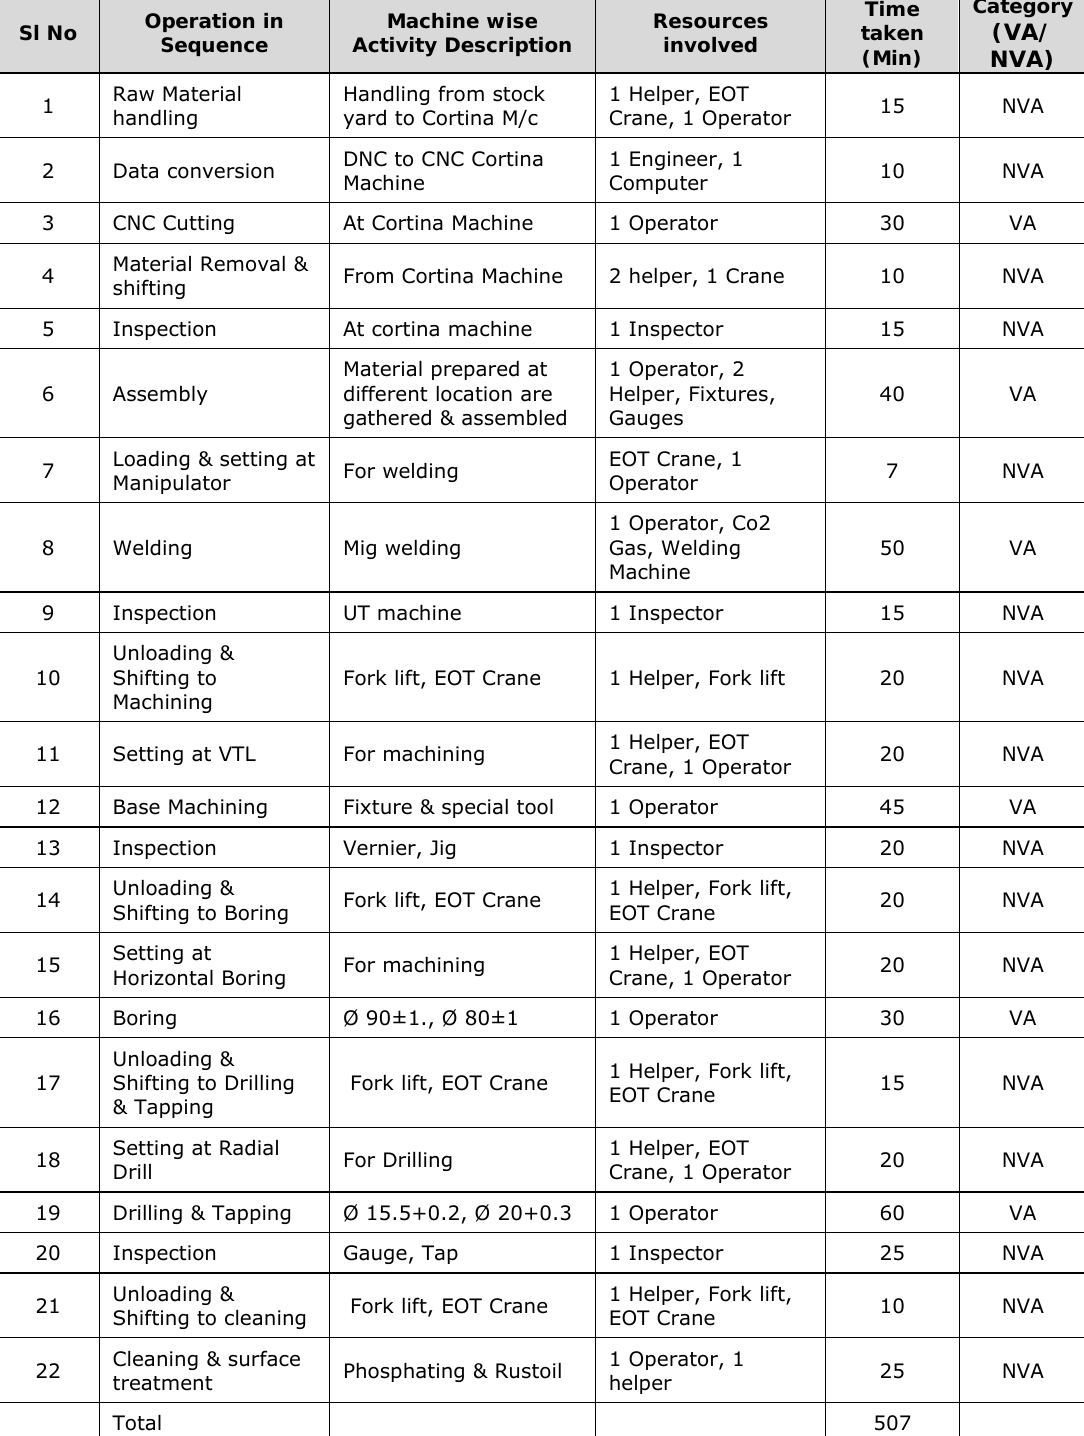
Table 8. “Value stream mapping after root cause